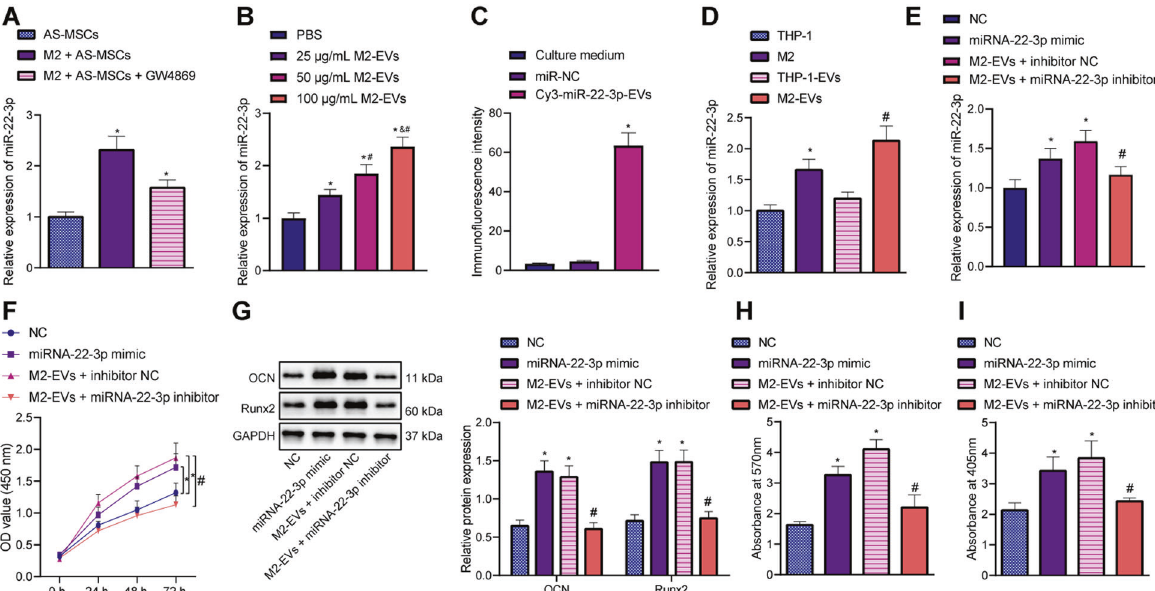
Fig. 2 Effects of M2-EVs carrying miR-22-3p on the osteogenic differentiation of AS-BMSCs. A miR-22-3p expression determined by RT- qPCR in AS-BMSCs cocultured with M2-EVs or those treated with 5 μ M GW4869. B miR-22-3p expression determined by RT-qPCR in AS-BMSCs cocultured with M2-EVs at different concentrations. C Uptake of M2-EVs carrying Cy3 – miR-22-3p by AS-BMSCs observed under a fl uorescence microscope. Cy3-labeled miR-22-3p was red, DAPI-stained nuclei were blue, and phalloidin-labeled cytoskeleton was green. D miR-22-3p expression determined by RT-qPCR in THP-1 cells, M2 macrophages, M2-EVs, and THP-1-EVs. E miR-22-3p expression in AS-BMSCs treated with M2-EVs and/or miR-22-3p mimic/inhibitor determined by RT-qPCR. F The viability of AS-BMSCs treated with M2-EVs and/or miR-22-3p mimic/ inhibitor detected by CCK-8 assay. G The protein expression of Runx2 and OCN in AS-BMSCs treated with M2-EVs and/or miR-22-3p mimic/ inhibitor measured using Western blot analysis. H Mineralization of AS-BMSCs treated with M2-EVs and/or miR-22-3p mimic/inhibitor detected using Alizarin red staining. I ALP content of AS-BMSCs treated with M2-EVs and/or miR-22-3p mimic/inhibitor detected by ALP staining. * p < 0.05 vs. AS-BMSCs treated with PBS/THP-1/NC, # p < 0.05 vs. AS-BMSCs treated with 25 μ g/mL M2-EVs/THP-1-EVs /M2-EVs + inhibitor NC, and p < 0.05 vs. AS-BMSCs treated with 50 μ g/mL M2-EVs. The cell experiment was repeated three times